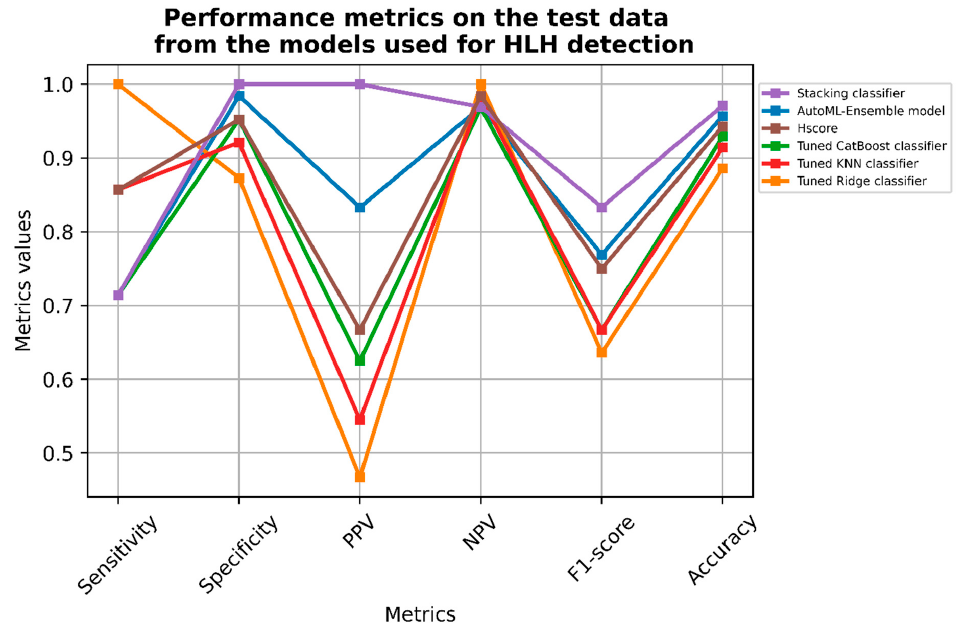
Figure 2. Line plot representing the main metrics values of each model used in the study. Abbreviations: KNN: K nearest neighbors; ML: machine learning; PPV: positive predictive value; and NPV: negative predictive value.